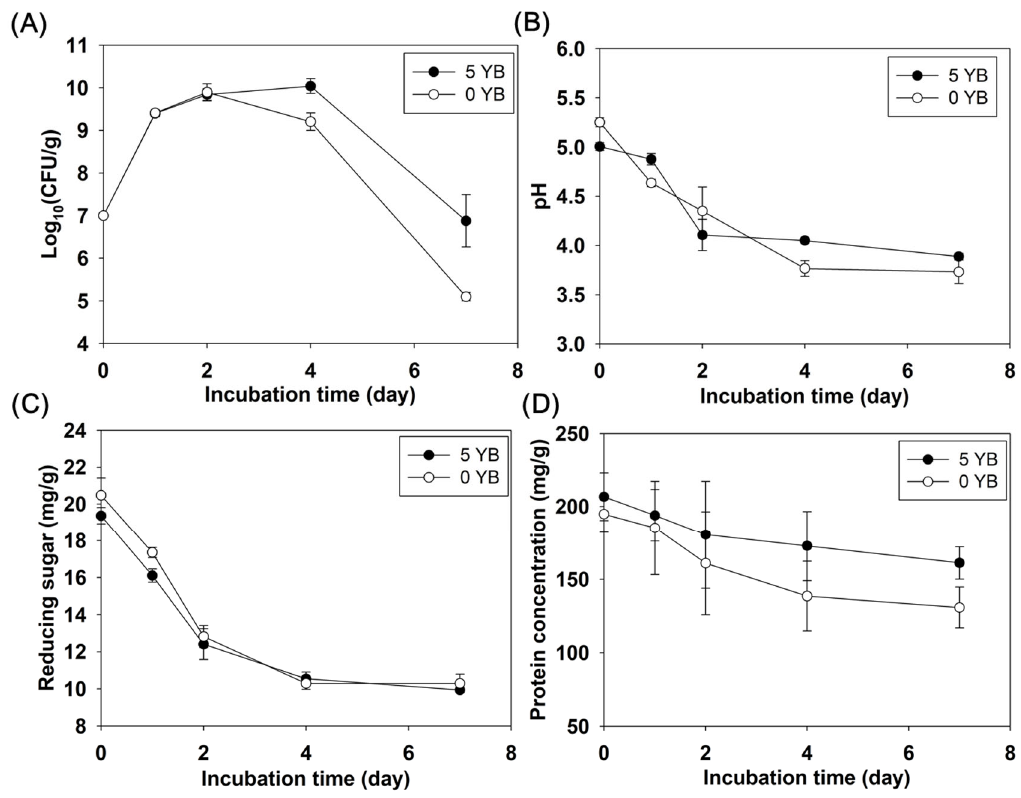
Figure 2. General characteristics of the sterile solid ‐ state Lp ‐ fermented B. papyrifera with (5YB) or without (0YB) 5% (wt/vol) yeast by ‐ product supplementation. ( A ) Growth ability, ( B ) pH change, ( C ) reducing sugar content, and ( D ) protein concentration.